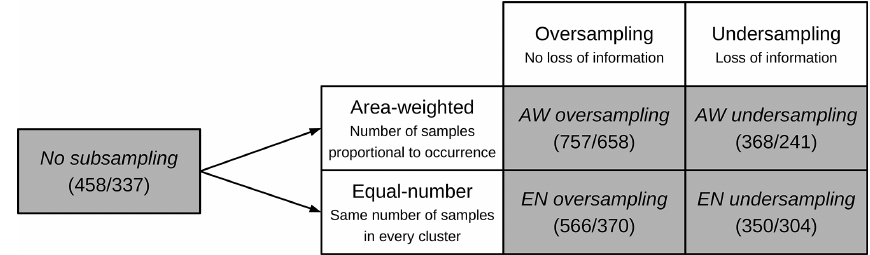
Figure 3. Applied sampling approaches. Parentheses show the number of samples in the training set (10 and 70cm depth, respectively). Abbreviations of the sampling methods as used in the results are shown in